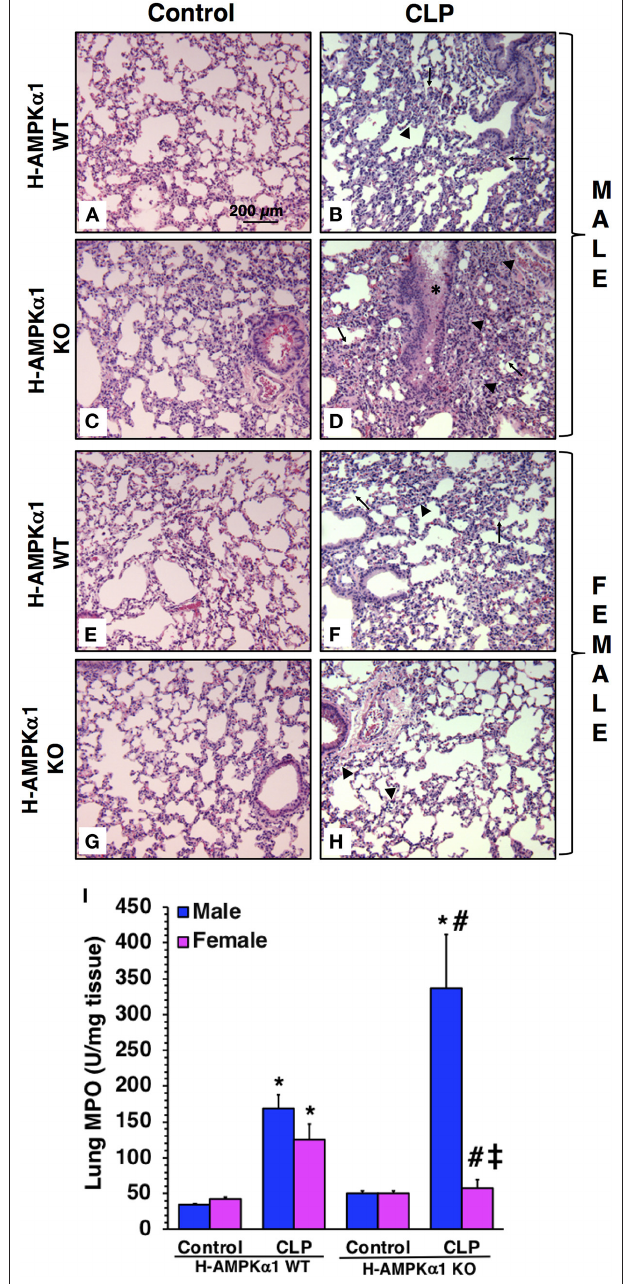
FIGURE 4 | Representative histology photomicrographs of lung sections of hepatocyte-specific (H-AMPK α 1) wild-type (WT) and knock-out (KO) male (A–D) and female (E–H) mice at baseline conditions (Control) or 18h after cecal ligation and puncture (CLP). Lung damage in H-AMPK α 1 WT male (B) and female (F) mice with modest infiltration of inflammatory cells ( arrow heads ) and reduced alveolar space ( arrows ). Lung damage in H- AMPK α 1 KO male mice (D) with reduced alveolar space, bronchial congestion ( asterisk ) and accumulation of red and inflammatory cells. Mild lung damage in H-AMPK α 1 KO female mice (H) with mild infiltration of inflammatory cells only. (Continued)